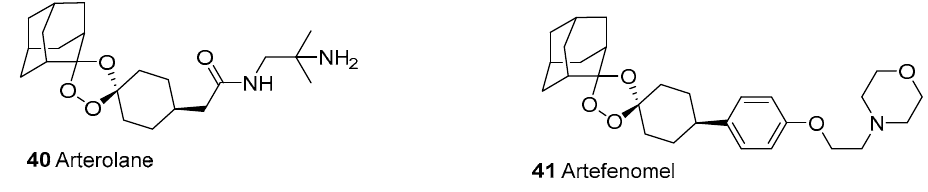
Figure 13. Recent antimalarial drugs expected to overcome resistance among mutated parasites. Both ferroquine ( 26 ) and artefenomel ( 41 ) are synthetic drugs, which can be prepared on a large